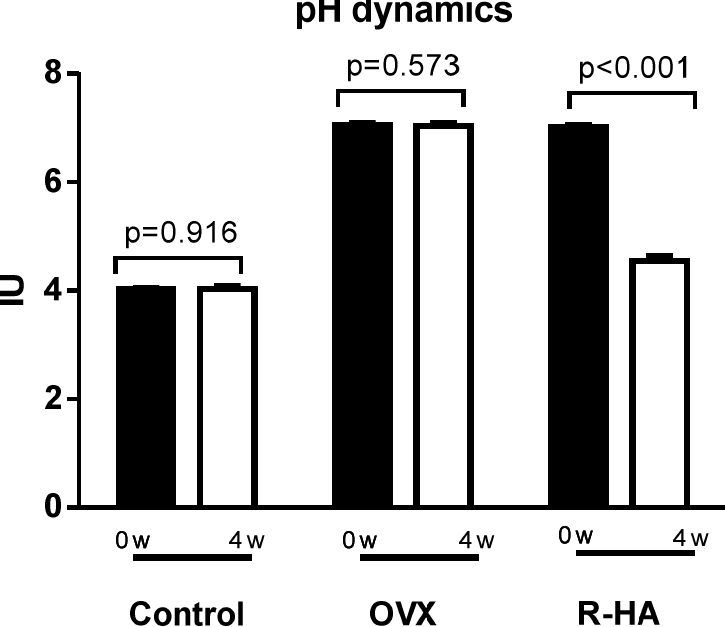
Figure 4. The value of the vaginal pH in control, OVX animals, and in female rats before and after R-HA topical treatment. Data expressed as mean ± SEM. For comparison, paired sample t -tests were used.